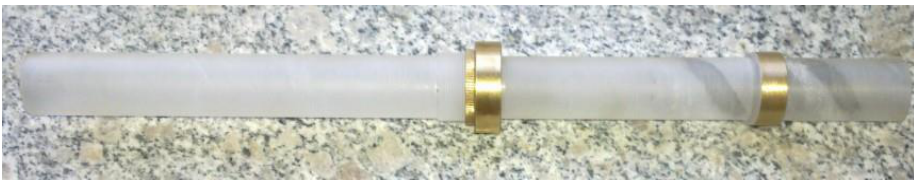
Figure 10. Central pipe physical map.